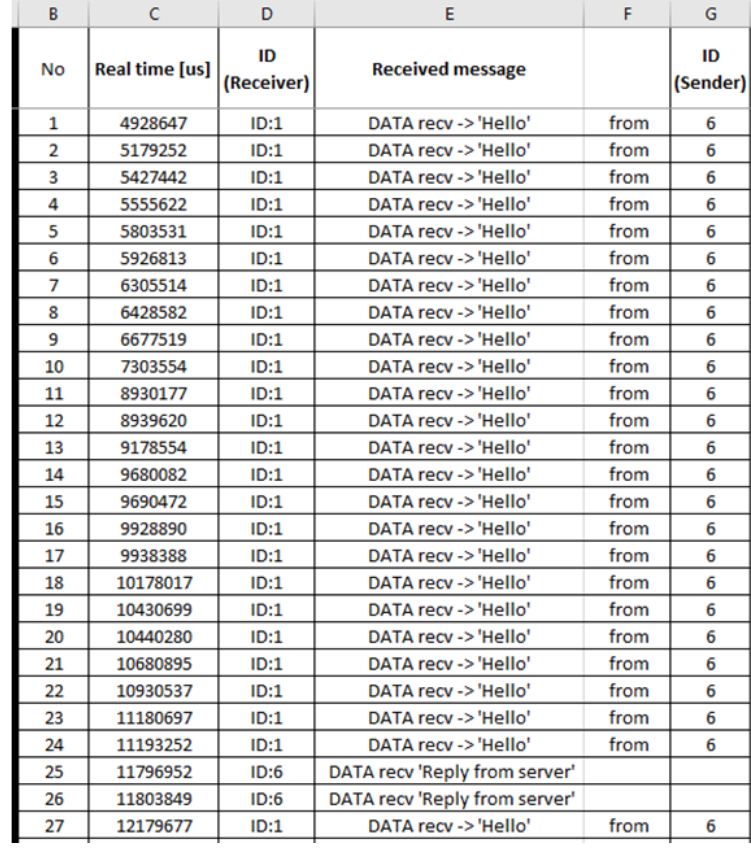
Figure 29. Malicious “pwrtrace.csv”— 10,757 to 10,794 records.